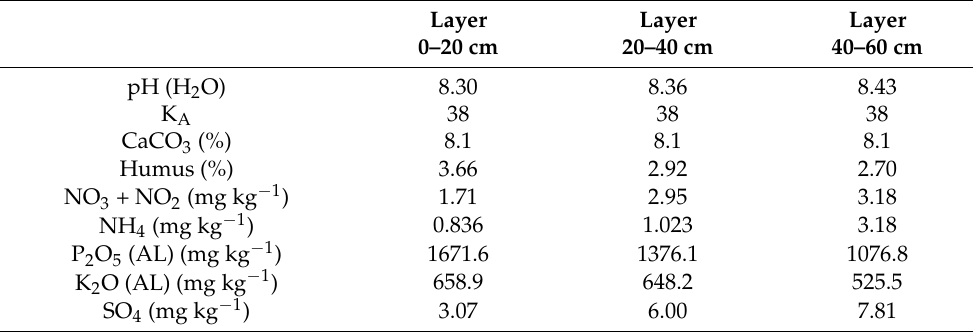
Table 5. Soil analysis results for the experimental site (2021,